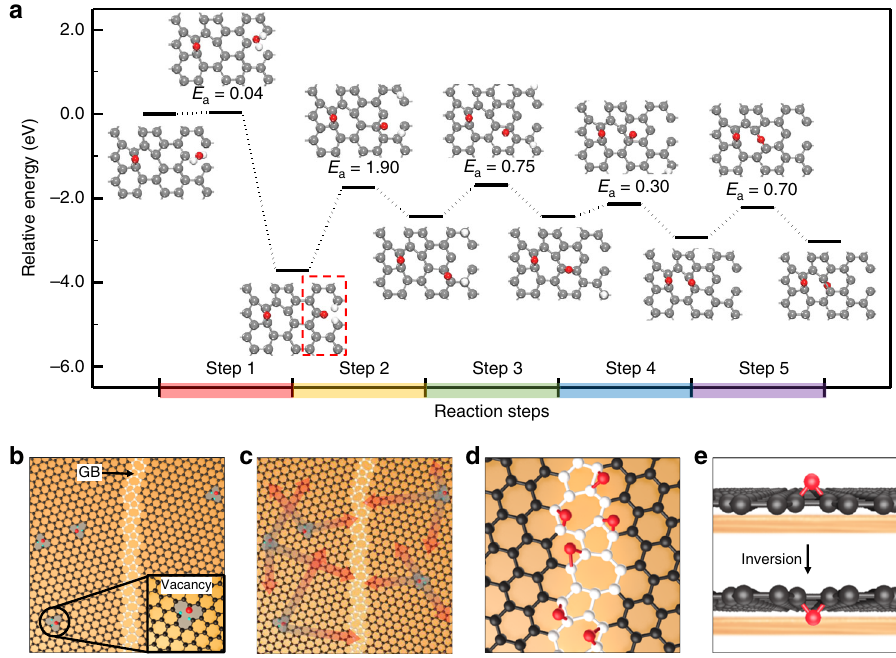
Fig. 5 Reaction pathway and schematics of the entire oxidation processes. a Minimum energy pathway of the entire reaction of oxidation (energy barriers ( E a ) in eV); started from the dissociation of water molecules at MVs and completed by the inversion of radical O atoms at GBs of graphene on Cu(111) substrate. The gray, white and red spheres indicate the C, H and O atoms, respectively. The diagrams represent the elementary steps of the Cu oxidation process including b the dissociative chemisorption of water vapors at point defects in Gr, c the migration of O adatoms on the Gr/Cu surface, d the accumulation of O atoms at the GBs of the Gr grains, and e the inversion of the O atoms at a SW defect with additional functional groups, followed by the selective oxidation of the Cu